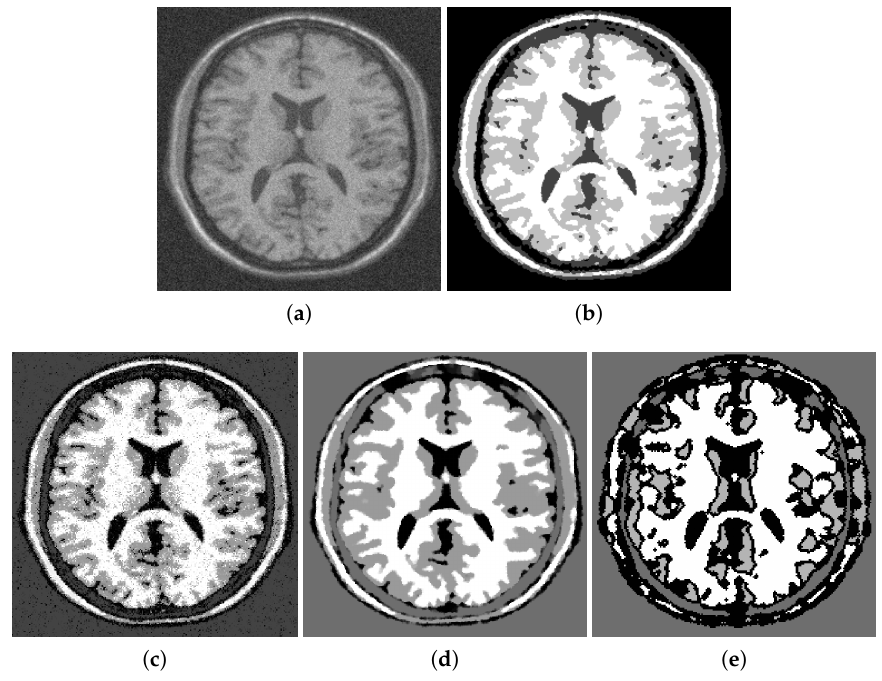
Figure 4. ( a ) Input image, ( b ) output of our segmentation method, ( c ) fuzzy segmentation [28], ( d ) graph cuts [14], ( e ) Vese–Chan